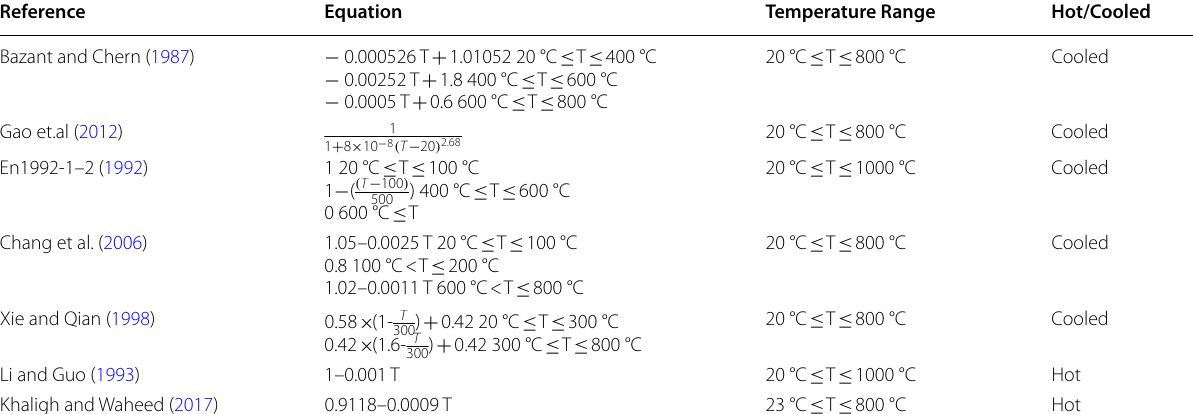
Table 6 Previous tensile strength equation at/after high-temperature exposure.